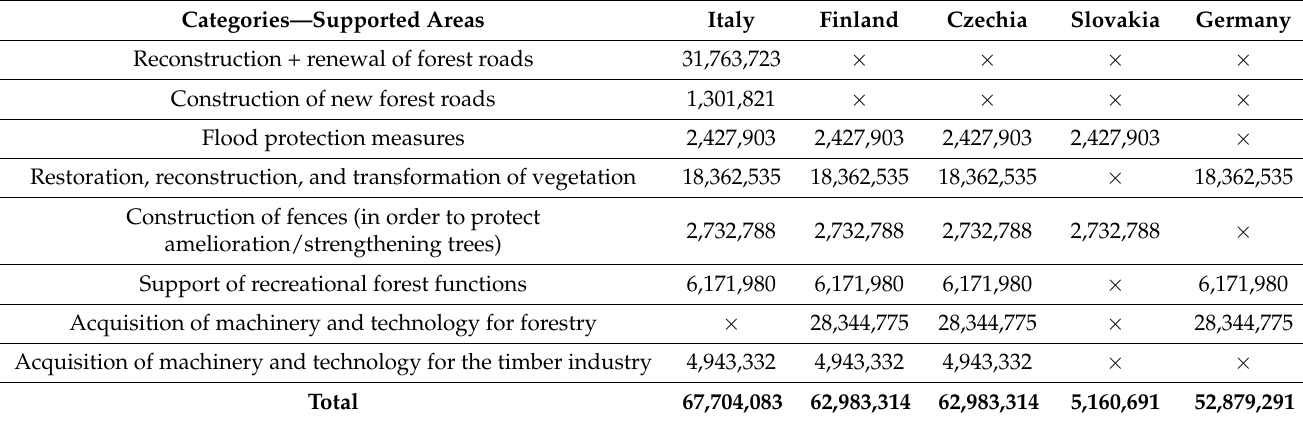
Table 5. Financial expression of the support of the FBE based on the individual RDP categories in the selected countries in EUR.